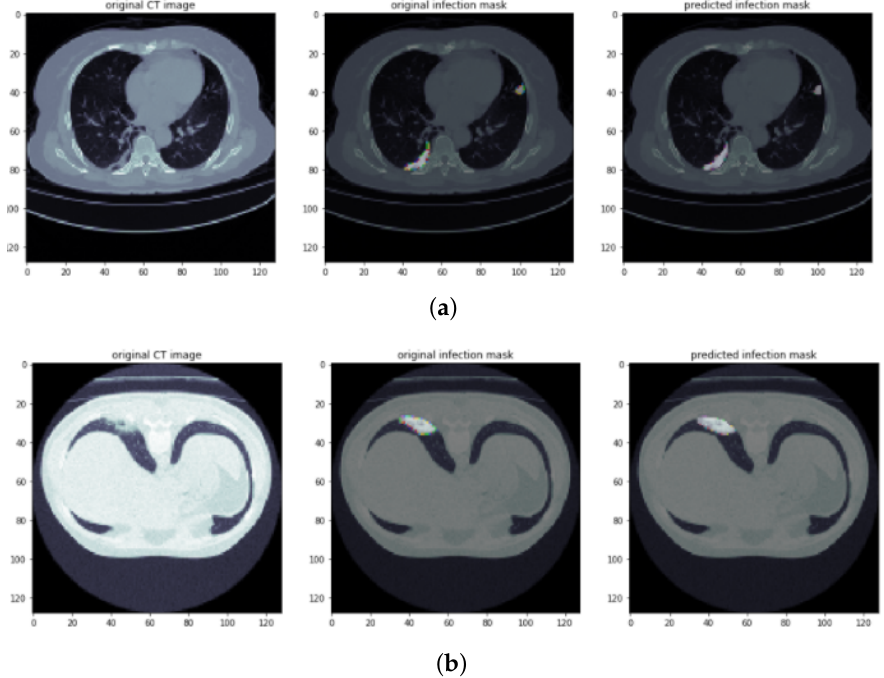
Figure 6. Infection segmentation results of CT scans: the sample images ( a , b ) show the early stage of viral infection. Columns 1–3 show an original CT scan image, an original infection mask, and a predicted infection mask, respectively.